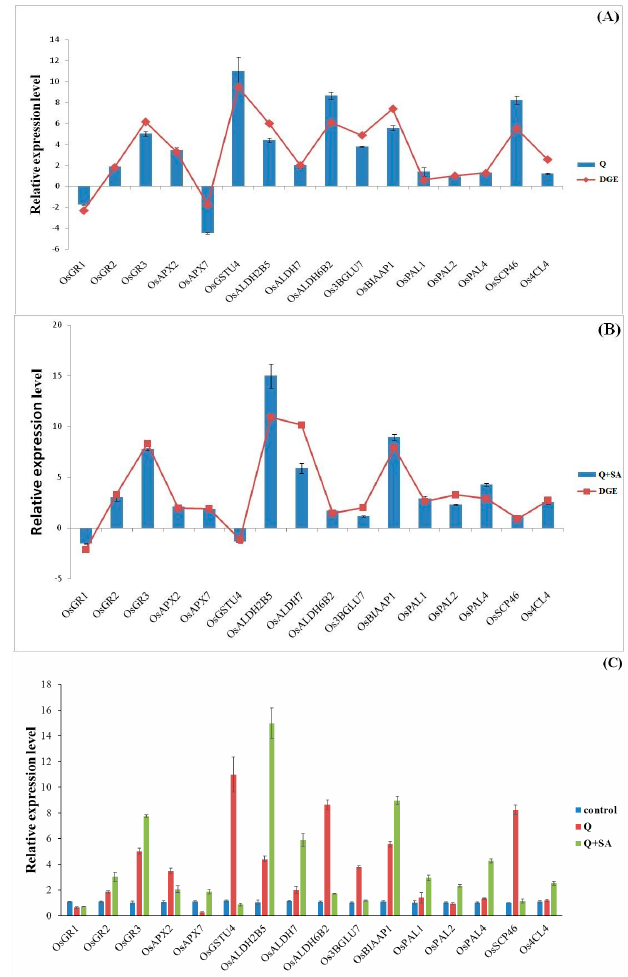
Figure 7. Confirmation of expression levels of selected differentially expressed genes (DEGs) by quantitative real time-PCR assays. ( A ) herbicide quinclorac treatment; ( B ) salicylic acid pre-treatment under quinclorac stress; and ( C ) various genes expression under different treatments. The data show the averages and the standard deviation of three independent samples.